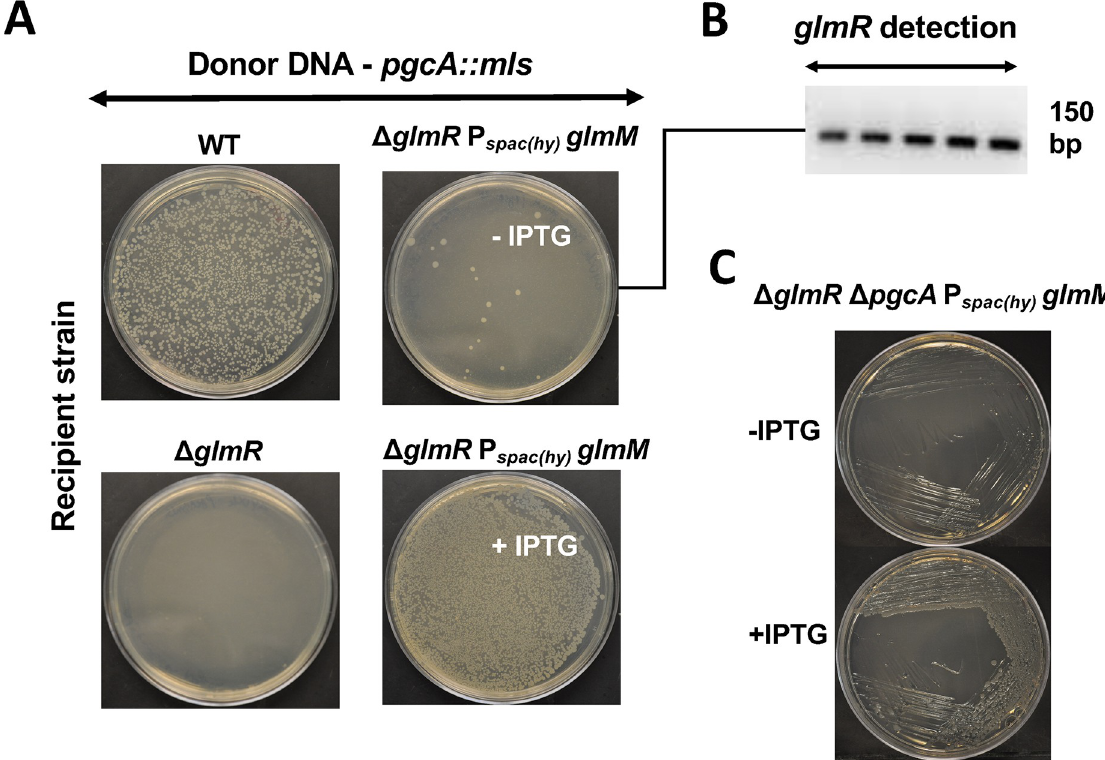
Fig 5. PgcA has PNGM activity B . subtilis . (A) WT, Δ glmR and Δ glmR P transformation carried out with pgcA :: mls strain spac(hy) glmM chromosomal DNA. Transformants were selected on LB containing MLS antibiotics and 20 mM MgSO 4. 1mM IPTG was added to the medium when necessary. (B) A representative agarose gel (N > 3) electrophoresis image showing PCR amplification of Δ glmR with internal check primers. (C) Representative pictures showing growth phenotype of Δ glmR Δ pgcA P spac(hy) glmM on MH agar plate with and without 1 mM IPTG.